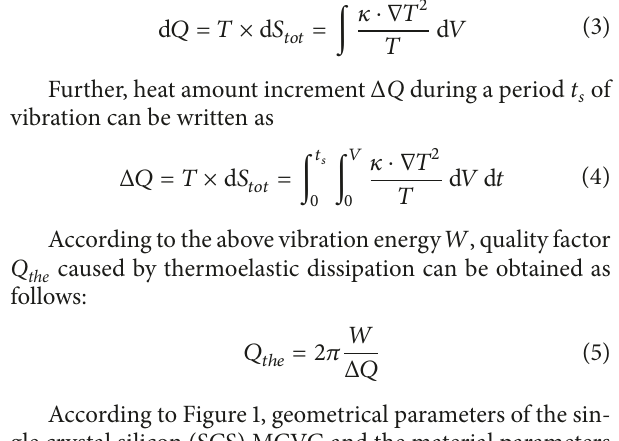
Figure 2: Energy distribution of thermoelastic damping of the MCVG at the temperature of 20 ∘